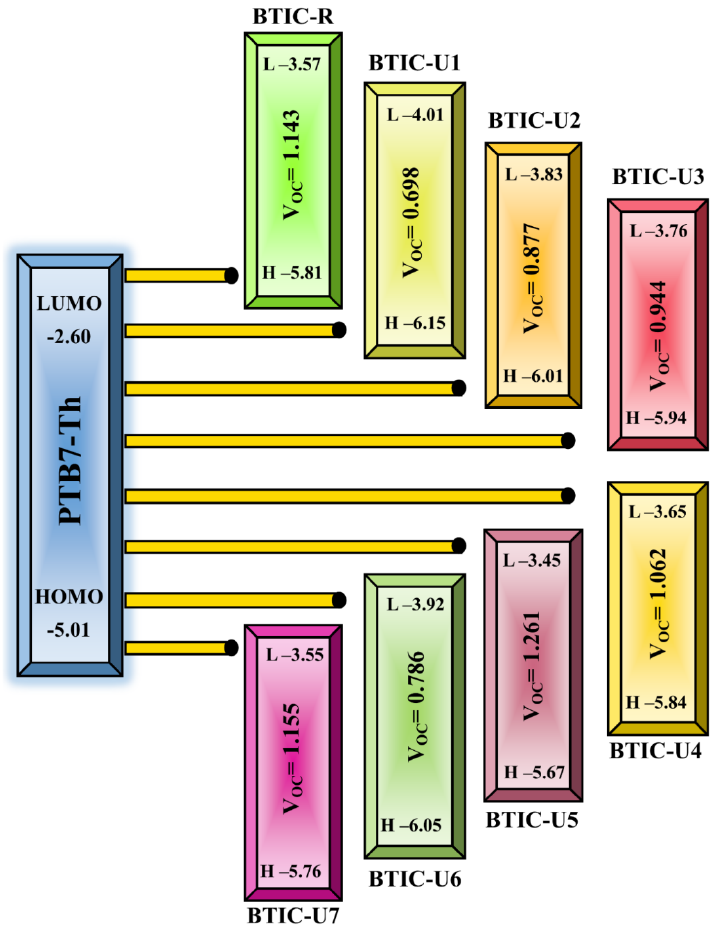
Figure 11. V OC of BTIC − R and BTIC − U1 to BTIC − U7 with respect to donor PTB7 − Th polymer. Table 9. The computed Voc, normalized Voc, FF, and PCE of BTIC-R and BTIC-U1 to BTIC-U7.